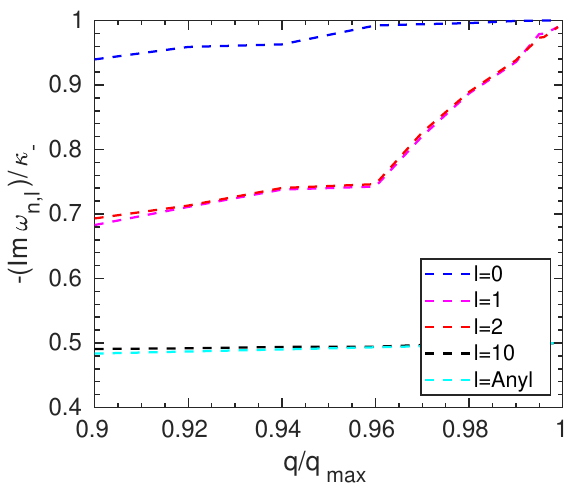
Figure 2 . In the above, we have depicted the ratio {− ( Im ω n,l ) /κ − } against ( q/q max ) for different choices of the angular momentum ‘ and for AdS radius and mass L = 2 and M = 1 , respectively. The lowest lying curve corresponds to β and is always less than the critical value (1 / 2)